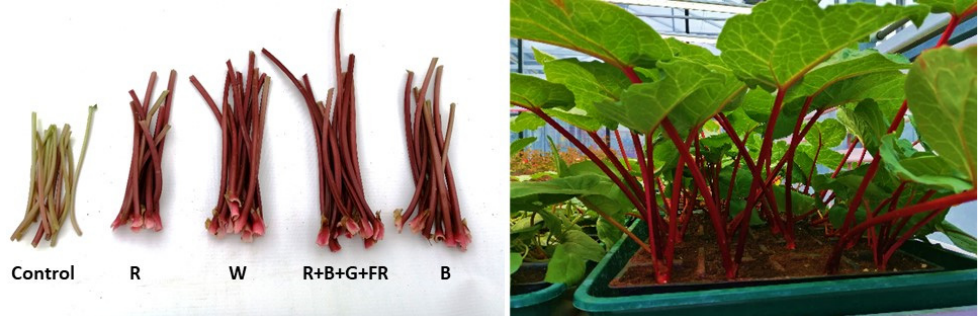
Figure 5. Phenotypic characteristics of the rhubarb ‘Raspberry’ plantlets after 10 weeks of growth in the greenhouse: on the left—the leaf petioles of plantlets grown in Floragard substrate under different light conditions (control—natural light, R—red, W—white, B—blue, R+B+G+FR—far red); on the right, the rhubarb plantlets grown in Floragard substrate (GM1) under R+B+G+FR-LEDs.